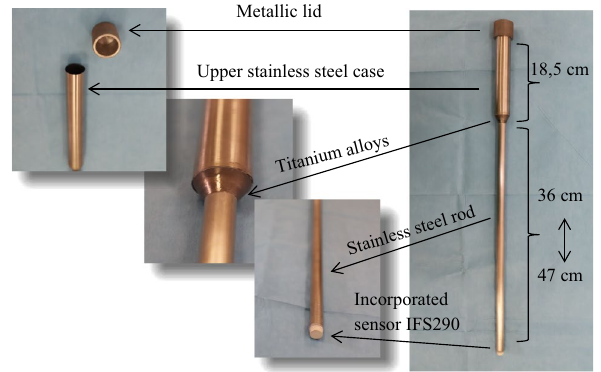
Figure 2. The modular laparoscopic detection instrument composed from a proximal handle that hosts the electronic block covered by a lid to preserve an sterile environment on the surface (corner left), the titanium alloy at the junction between the case and the rod (middle left), the inductive sensor present at the distal tip of the instrument, encapsulated in a watertight junction (middle right). Overview of the whole instrument